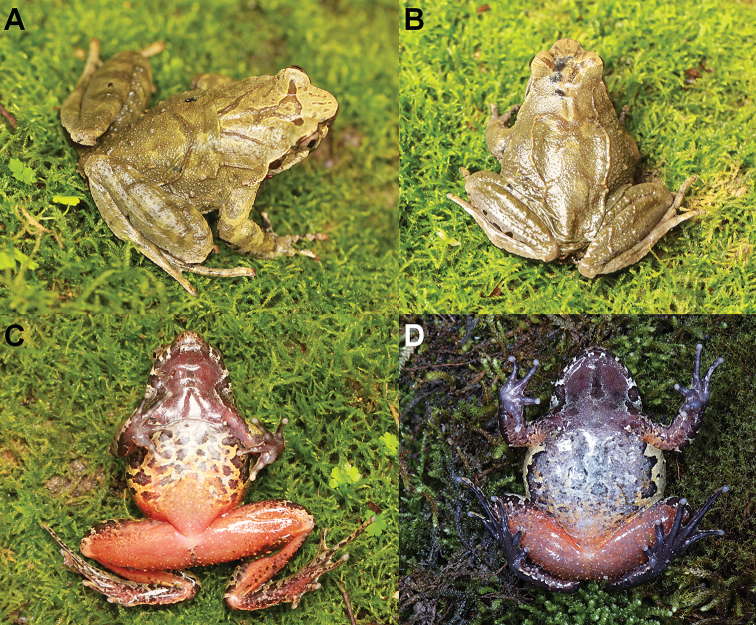
Color variation in Megophrys
qianbeiensis sp. nov. A dorsolateral view of the specimen CIBTZ20160715003 B dorsolateral view of the specimen CIBTZ20190608015 C ventral view of the male specimen CIBTZ20190608015 D ventral view of the specimen CIBKKS20180722001.